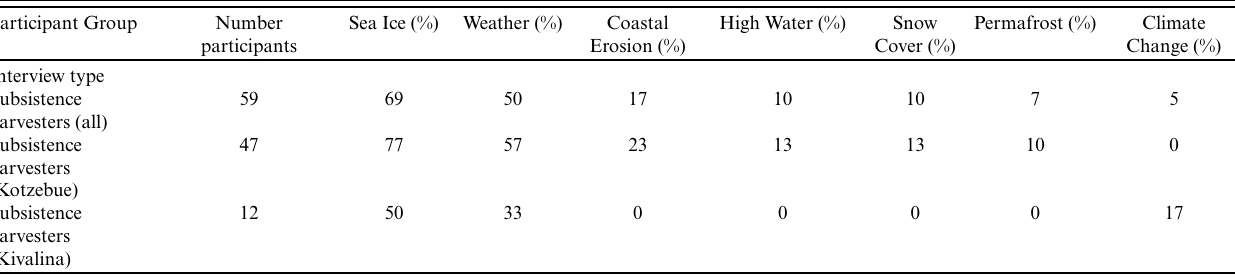
Table 1 . Sample size of interviewees by participant group and percentage of each participant group that mentioned an environmental access challenge. Couple and group interviews were counted by the individuals